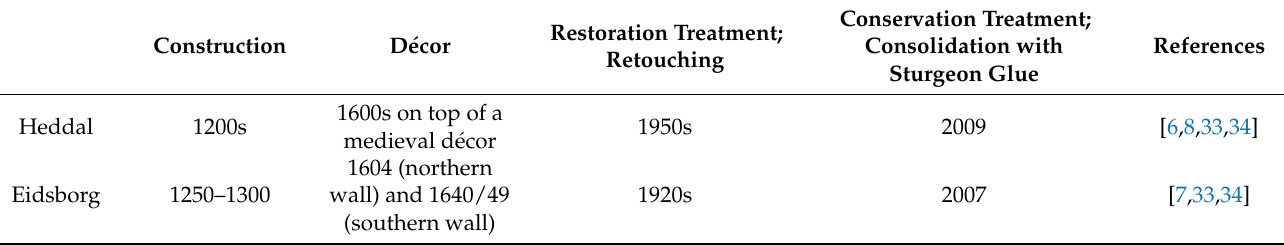
Figure 2. Case study of two stave churches in Vestfold and Telemark county: ( a ) Heddal and ( b ) Eidsborg. Table 1. Restoration and conservation treatments.